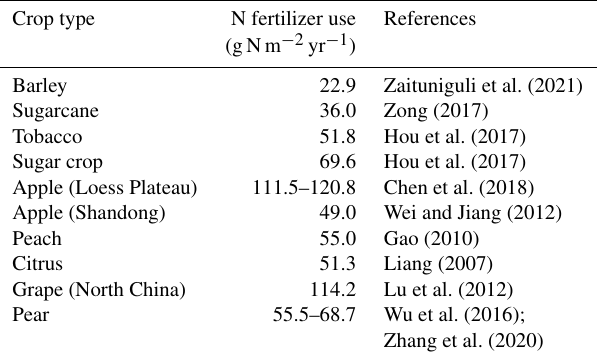
Table 3. Nitrogen (N) fertilizer use rates in minor crops reported in